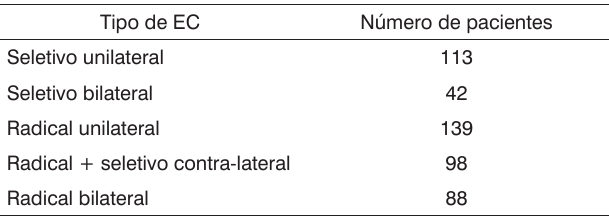
Tabela 2. Tipos de EC